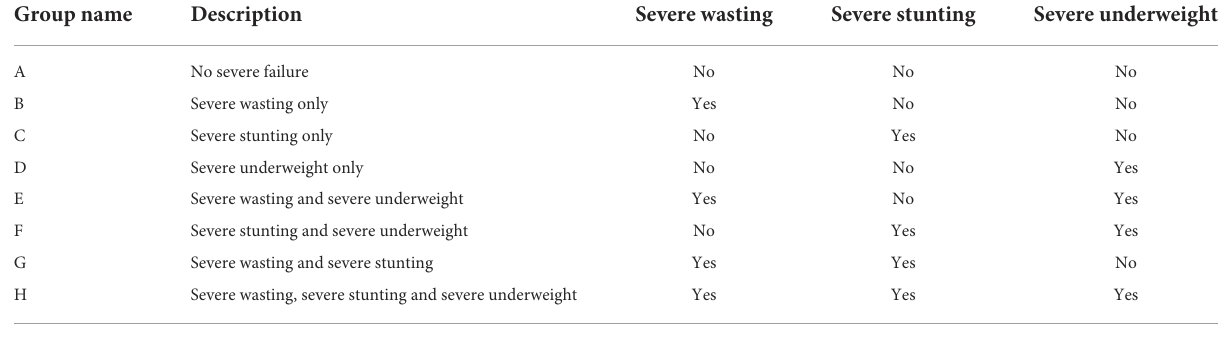
TABLE 1 Classification of children with severe anthropometric failure.